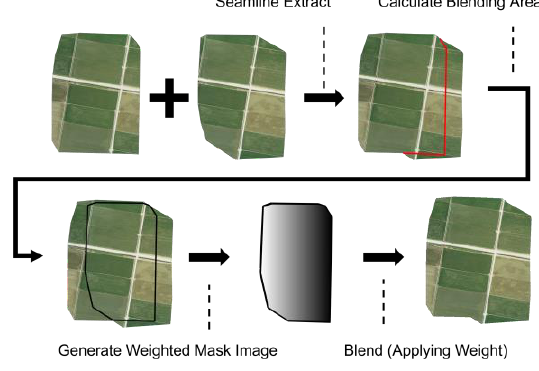
Figure 4. Blending method with weighted mask image Figure 5. Blending process of two image